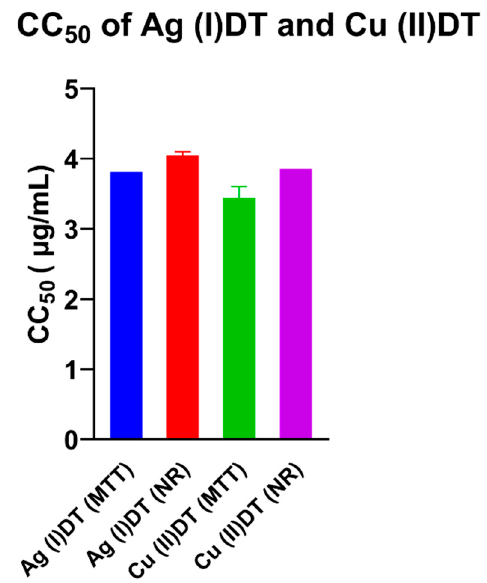
Figure 10. Half-maximal cytotoxic concentration of silver(I) and copper (II) dithiocarbamate com- plexes in 80% confluent TZM-bl cells. The chemical compounds were used at a starting concentration of 11 μ g/mL in both MTT and neutral red (NR) uptake assays.